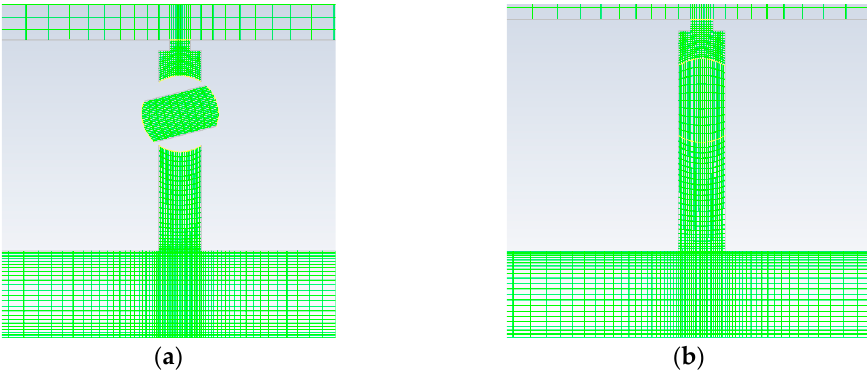
Figure 3. Schematic diagram of mesh at leakage hole B: ( a ) before valve opening; ( b ) after the valve is opened.